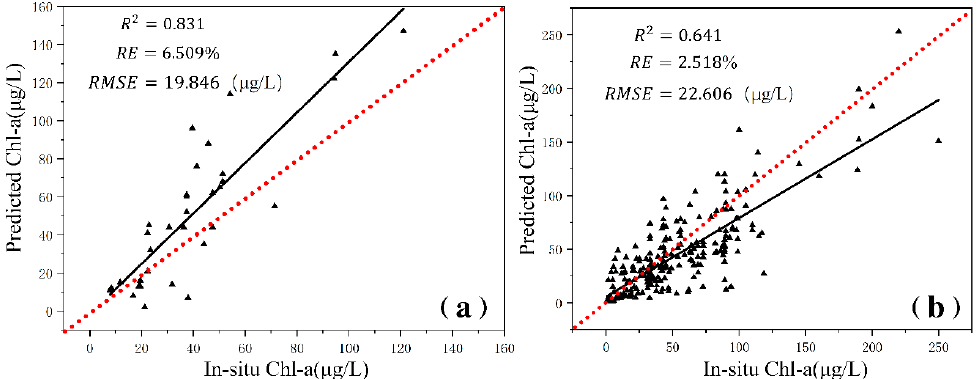
Figure 4. ( a ) Landsat-predicted versus actual Chl-a concentration. ( b ) Landsat-predicted versus actual Chl-a concentration (three long-term monitoring points from 2005 to 2018). The 1:1 line is represented by the red dashed line and the black solid line represents the observed correlation between the Landsat estimated values and actual measured